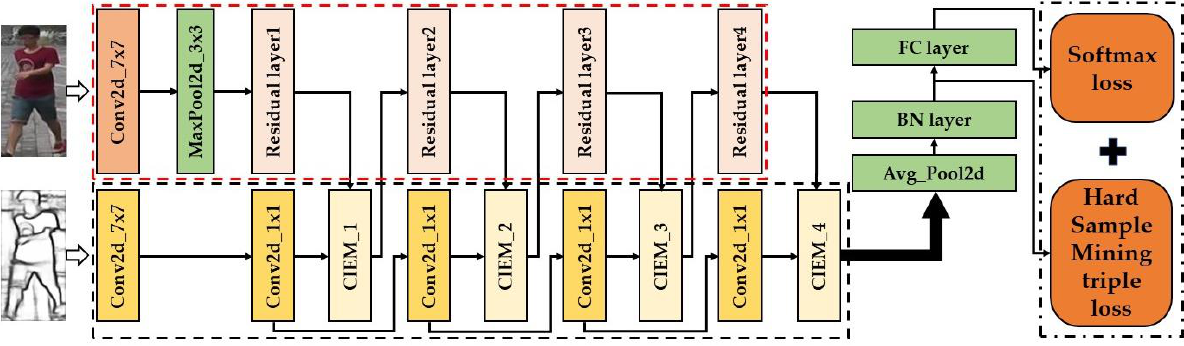
Figure 3. The architecture diagram of the method proposed in this paper.